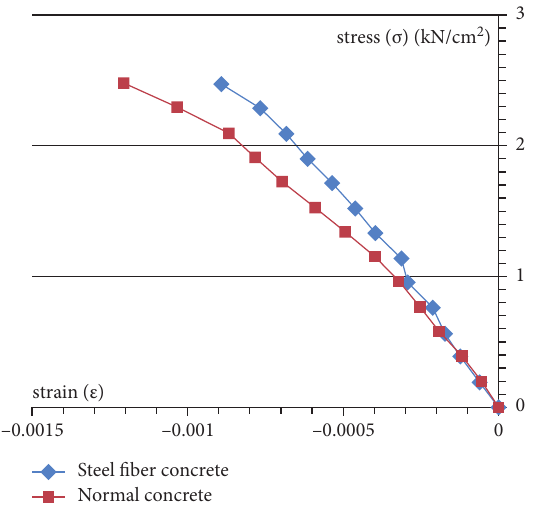
Figure 7: Stress-strain relationship of the two types of concrete.